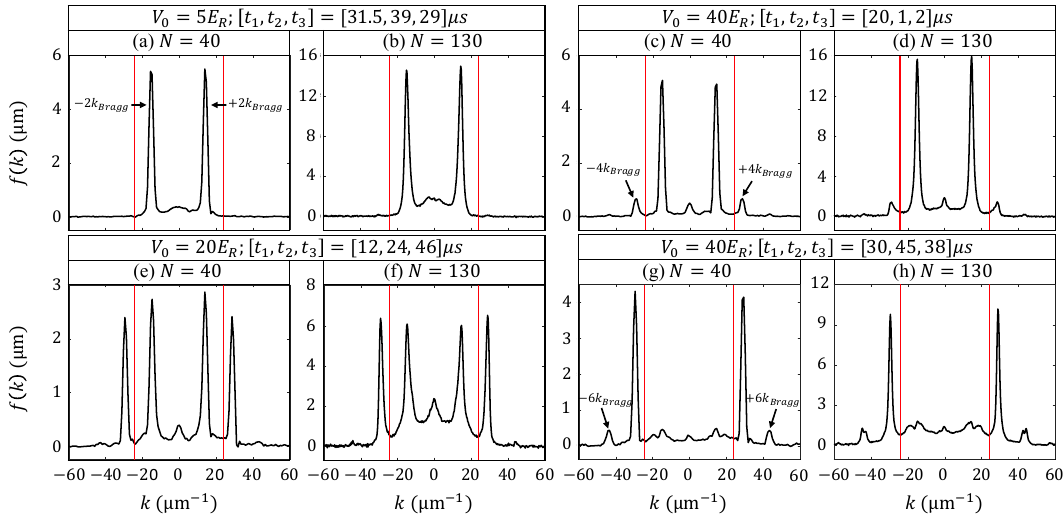
Figure 3: Initial MDFs (experimental measurements) and their corresponding Bragg pulse sequences. The pulse intensity V The red vertical lines indicate the momenta ± k th